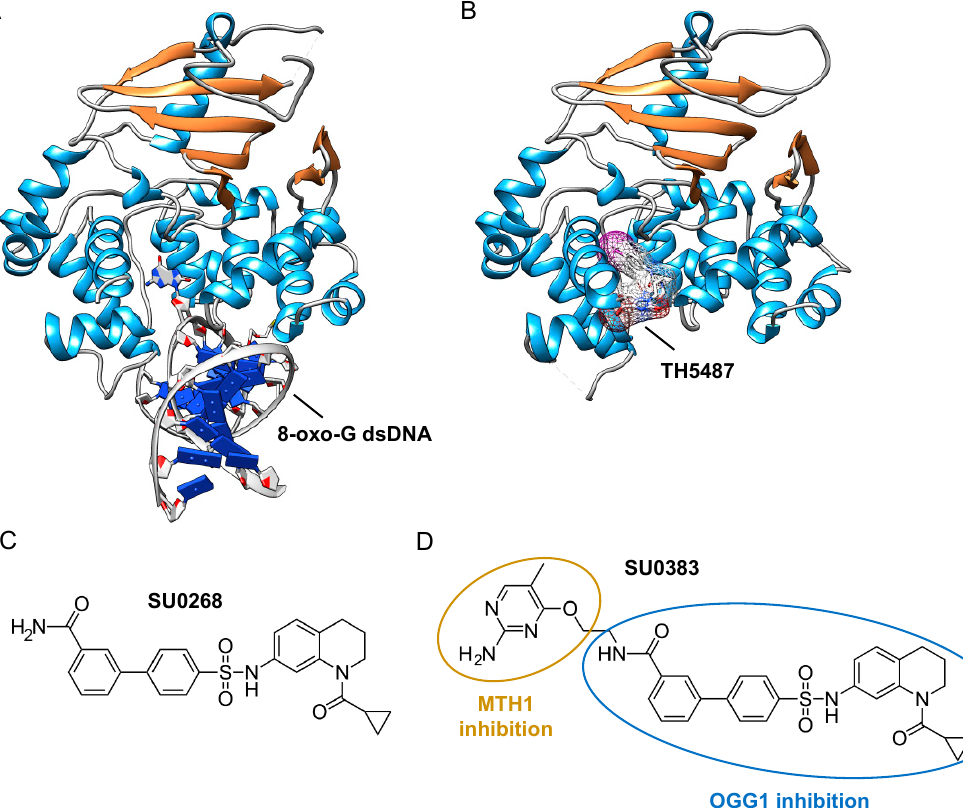
Figure 4. Identification of specific inhibitors of human OGG1. ( A ) Crystal structure of human OGG1 crosslinked to 8-oxo-G containing dsDNA (PDB: 6W0M; [201]). ( B ) Crystal structure of human OGG1 bound to an active site-specific inhibitor, TH5487 (PDB 6RLW), represented in ball and sticks and as a transparent mesh. ( C ) Chemical structure of the highly specific OGG1 inhibitor selected by Tahara and colleagues [197], SU0268. ( D ) Chemical structure of the dual inhibitor, SU0383, which efficiently blocks both MTH1 and OGG1 activities [202].